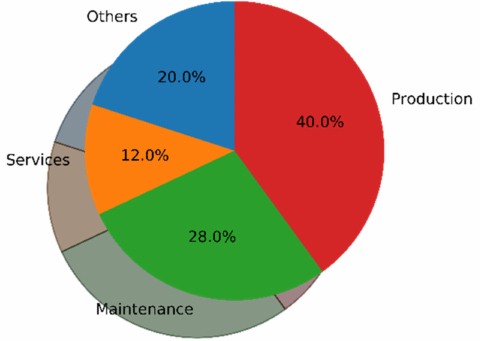
Figure 2. Application areas of Digital Twins according to Melesse et al. (reproduced from [15], Elsevier,